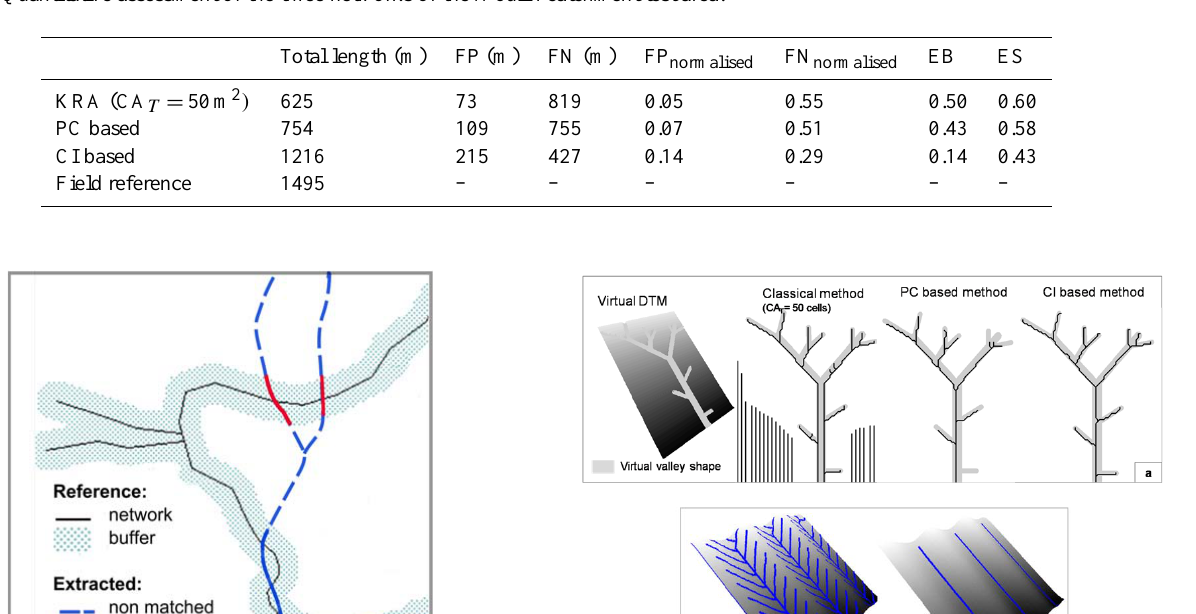
Table 1. Quantitative assessment of the three networks of the Moulin catchment test area.